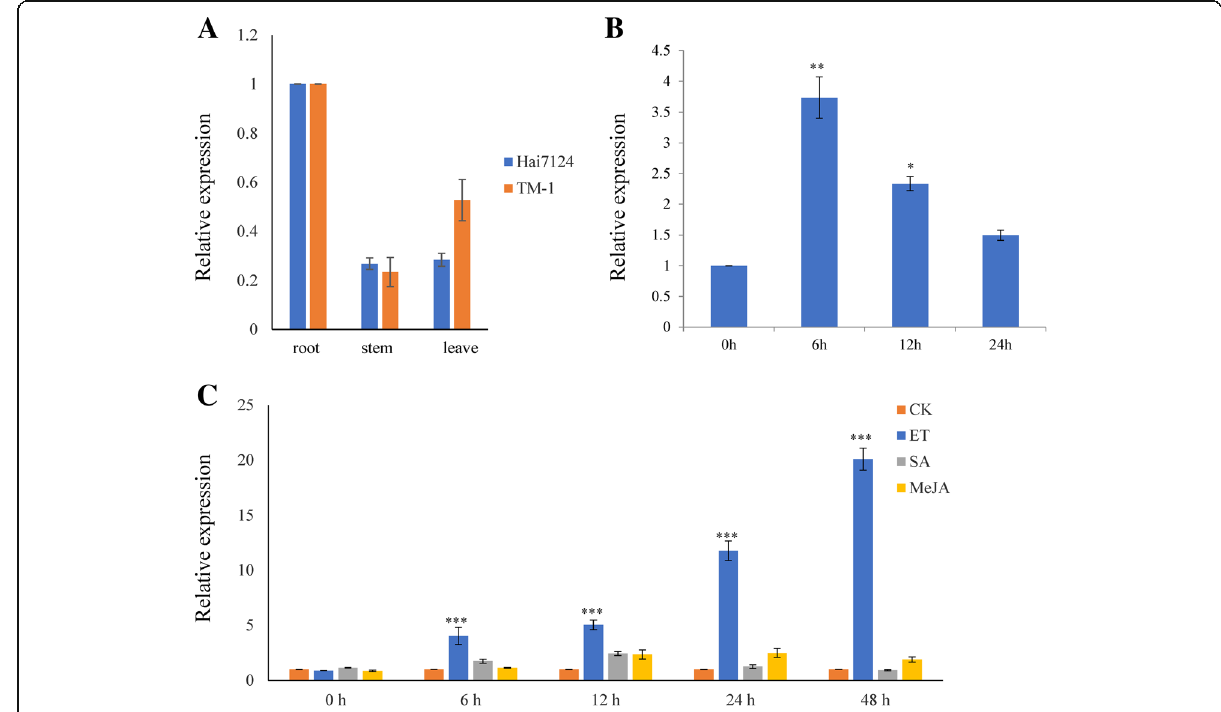
Fig. 2 Expression patterns of VIP1 gene under different conditions. a Tissue-specific expression of VIP1 . b Expression pattern of VIP1 induced by V. dahliae . c Expression pattern of VIP1 under exogenous treatment of plant